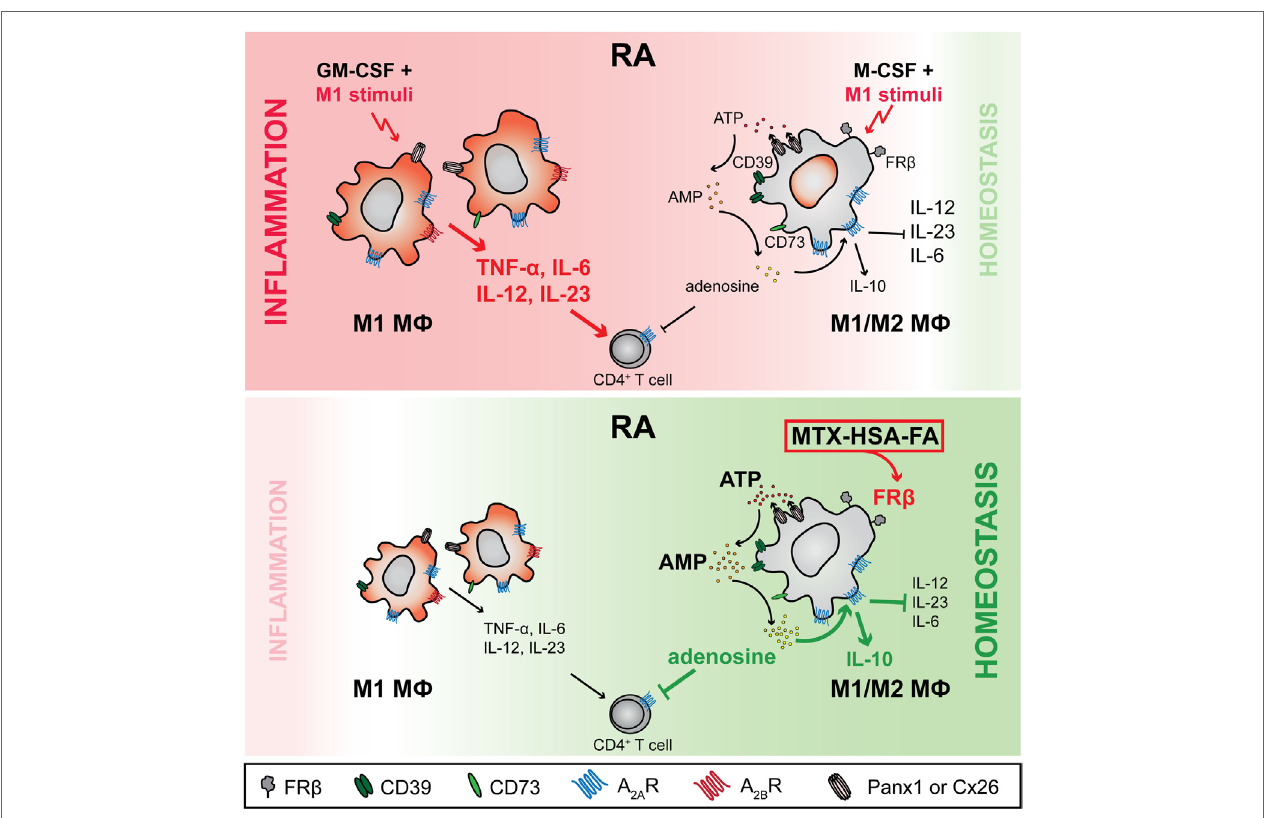
FigUre 8 | Working model—purinergic signaling differs in M-CSF- and GM-CSF-dependent macrophages (M ϕ s): FR β -targeted delivery of methotrexate (MTX) can restore homeostasis by boosting adenosine production in chronic inflammatory disorders. In rheumatoid arthritis (RA), M ϕ s depending on M ϕ colony-stimulating factor (M-CSF) and expressing high levels of folate receptor β (FR β ) and CD39, in response to proinflammatory stimuli upregulate ATP-releasing channels pannexin-1 (Panx1) and connexin-26 (Cx26) as well as the ectonucleotidase CD73. As a direct consequence, this M ϕ subset produces high levels of extracellular adenosine, which acts in an autocrine fashion through adenosine 2A receptors (A 2A Rs) to inhibit proinflammatory M ϕ responses. In particular, the release of proinflammatory cytokines (IL-6, IL-12, IL-23) is decreased while secretion of anti-inflammatory IL-10 is induced. Further, they suppress autoreactive T cells in a paracrine fashion. In contrast, adenosine production by the FR β − /lo M ϕ s, the prevalent M ϕ species in RA joints, is inadequate due to a markedly lower expression of Panx1 and Cx26 and much reduced co-expression of CD39 and CD73. Furthermore, this GM-CSF-dependent M ϕ subset expresses the adenosine 2B receptor (A 2B R), which triggers upon recognition of adenosine IL-6 and IL-23 production, leading to an enhanced Th17 response. As a result, only FR β -targeted delivery of MTX to